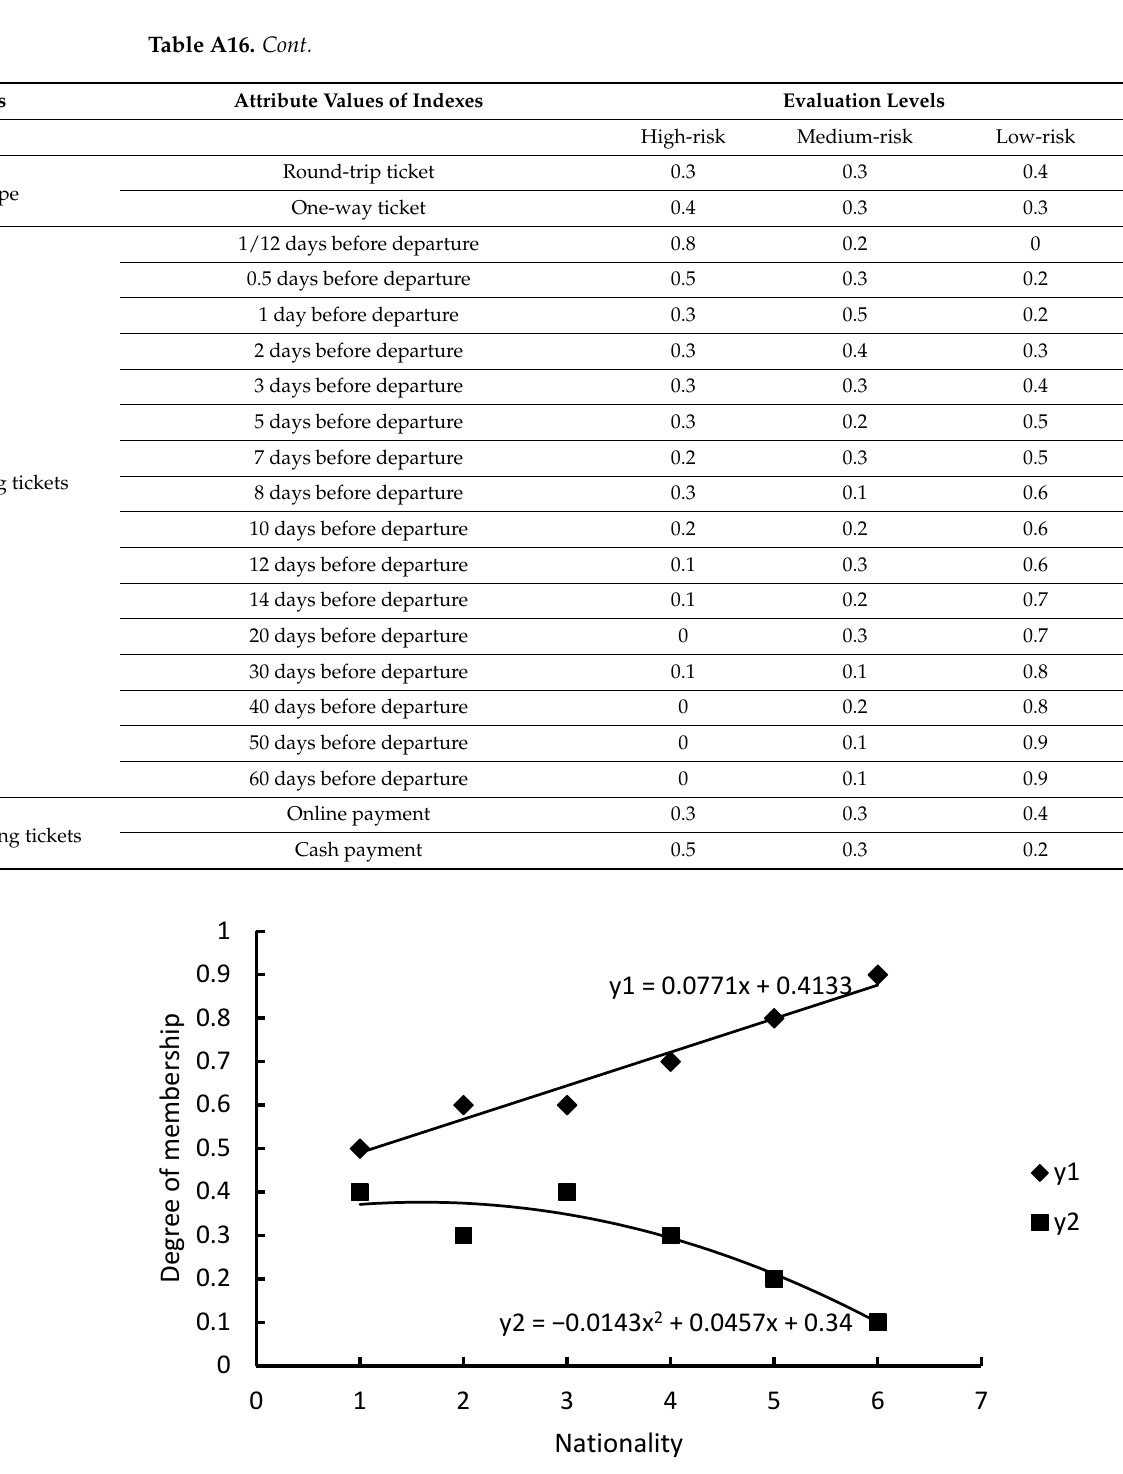
Figure A1. Single factor evaluation for the index of nationality.